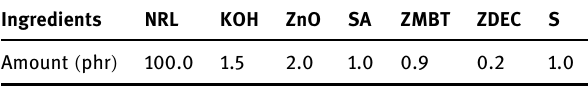
Table 1: Formulation for sample